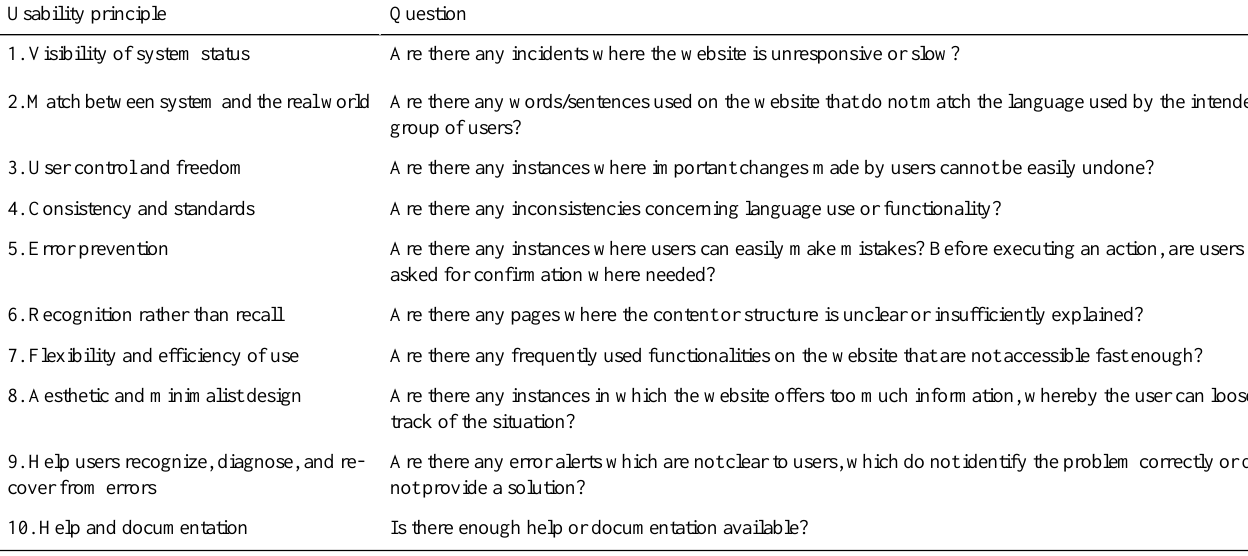
Table 1. Assessment criteria for heuristic evaluation QuestionUsability